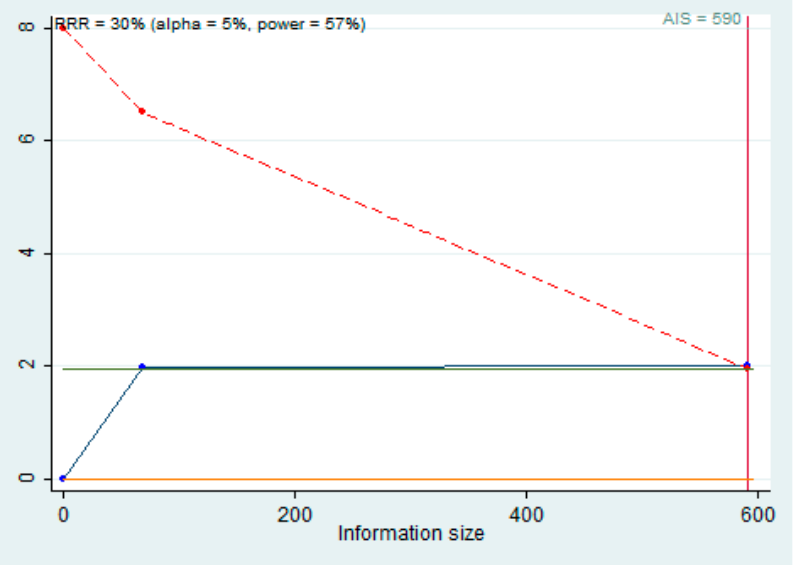
Figure 5. APIS, light green line (Z = 1.98); dashed red line (monitoring boundary); blue line (cumulative z curve); red line (sample size).